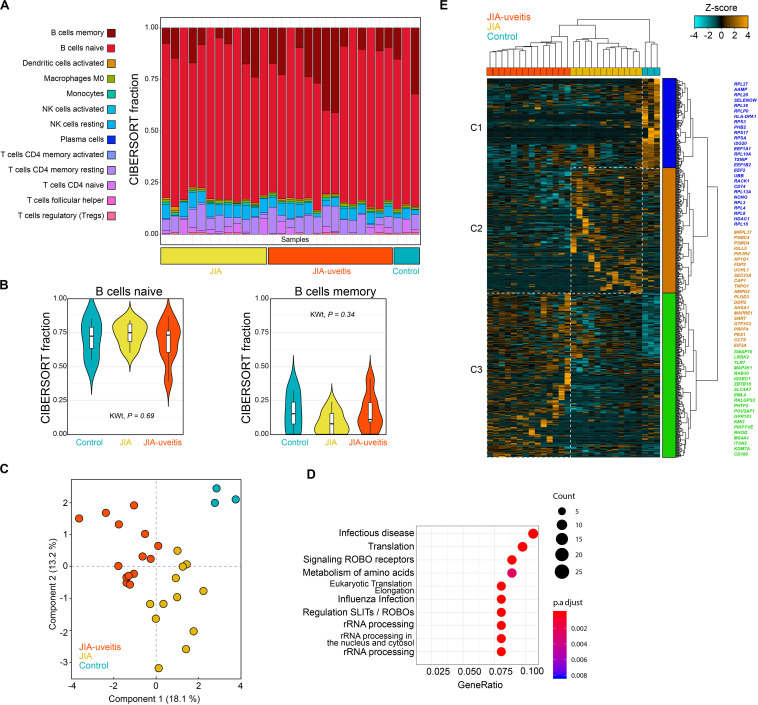
Blood CD19+ B cell transcriptomics in juvenile idiopathic arthritis-associated uveitis. (A) Deconvolution-based estimation of immune cell fractions using the RNA-sequencing data and CIBERSORT (25). The estimated cell fraction for each immune cell type in each sample is depicted in a stacked barplot (using the LM22 as signature sets to estimate the cell fractions) in the disease groups and controls. (B) The estimated cell fraction for naive and memory B cells for each of the disease groups and Kruskal–Wallis test statistic (KWt). (C) Principal component analysis of 614 DEGs at nominal significance (likelihood ratio test P < 0.05). (D) Pathway enrichment analysis of the 614 DEGs using the R package clusterProfiler with the Reactome database. (E) Hierarchical clustering of the 614 DEGs from the (C) using Euclidean distance and Ward’s method. Cluster 1–3 are indicated by different colors. A selection of genes associated to each cluster is indicated by the corresponding color (full list of genes and clusters are depicted in Supplementary Tables S4, S6).